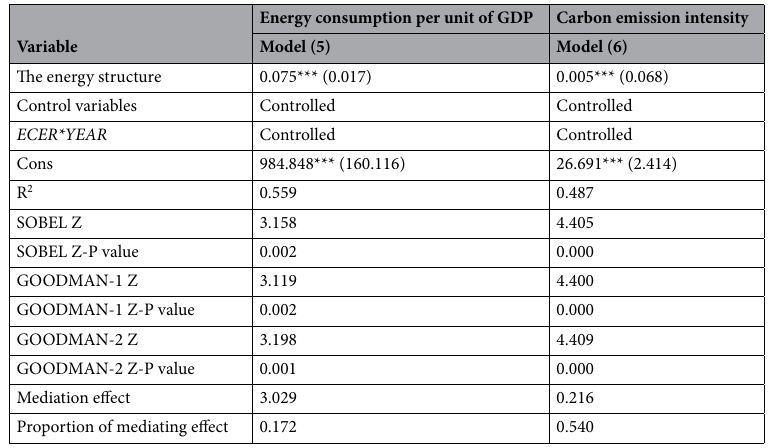
Table 8. Test results of mediation effect. In parentheses are standard errors, *, ** and *** indicate significance levels of 1%, 5% and 10%,